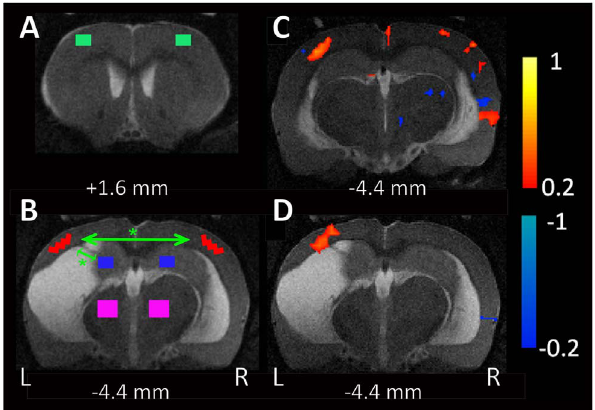
Figure 1. Decreased functional connectivity in TBI rats vs. controls. Two coronal MRI slices (A, B) from a rat with lateral FPI (note the tissue loss in the left hemisphere) demonstrating the brain regions of interest (ROIs) superimposed on coronal BOLD-fMRI images used for resting BOLD–fMRI signal correlation analysis. Four ROIs were made in each hemisphere (8 ROIs total): frontal cortex, parietal cortex, hippocampus, and thalamus (L, left; R, right). Panel B shows schematically using arrows the significant differences in connectivity (1) between the ipsilateral and contralateral parietal cortices and (2) between the ipsilateral parietal cortex and hippocampus in the rats with lateral FPI and sham-operation. Statistical significance: *, p , 0.05. (C) Example of resting functional connectivity in a sham-operated control rat. Pearson correlation values are shown using the left parietal cortex ROI (B) correlated to the whole brain. Some positive correlation is seen with the contralateral parietal cortex and ipsilateral hippocampus. (D) Example of the same analysis for the left parietal cortex ROI in a TBI animal shows reduced connectivity. Warm colors represent increases and cool colors decreases in connectivity; scale bars are for Pearson correlation with display threshold =0.2. Voxels lying outside the brain or in CSF are not